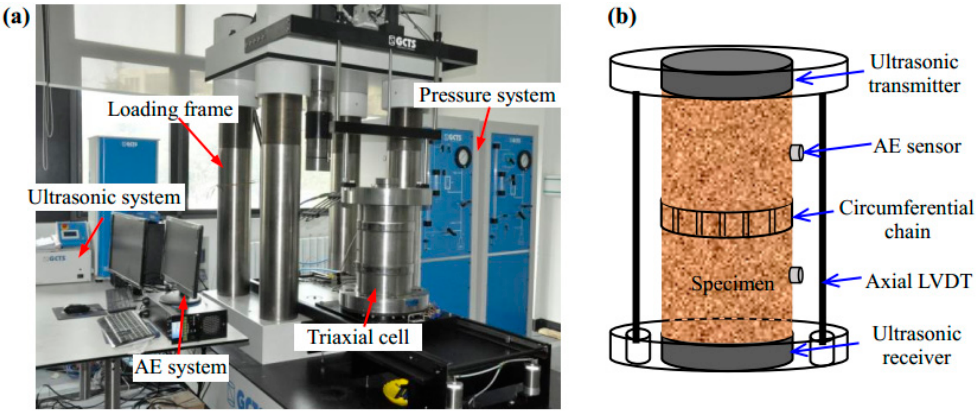
Figure 4. GCTS RTX–4000 rock triaxial testing system. ( a ) Overview of the testing system; and ( b ) Detail displacement, ultrasonic wave and acoustic emission (AE) measurement.